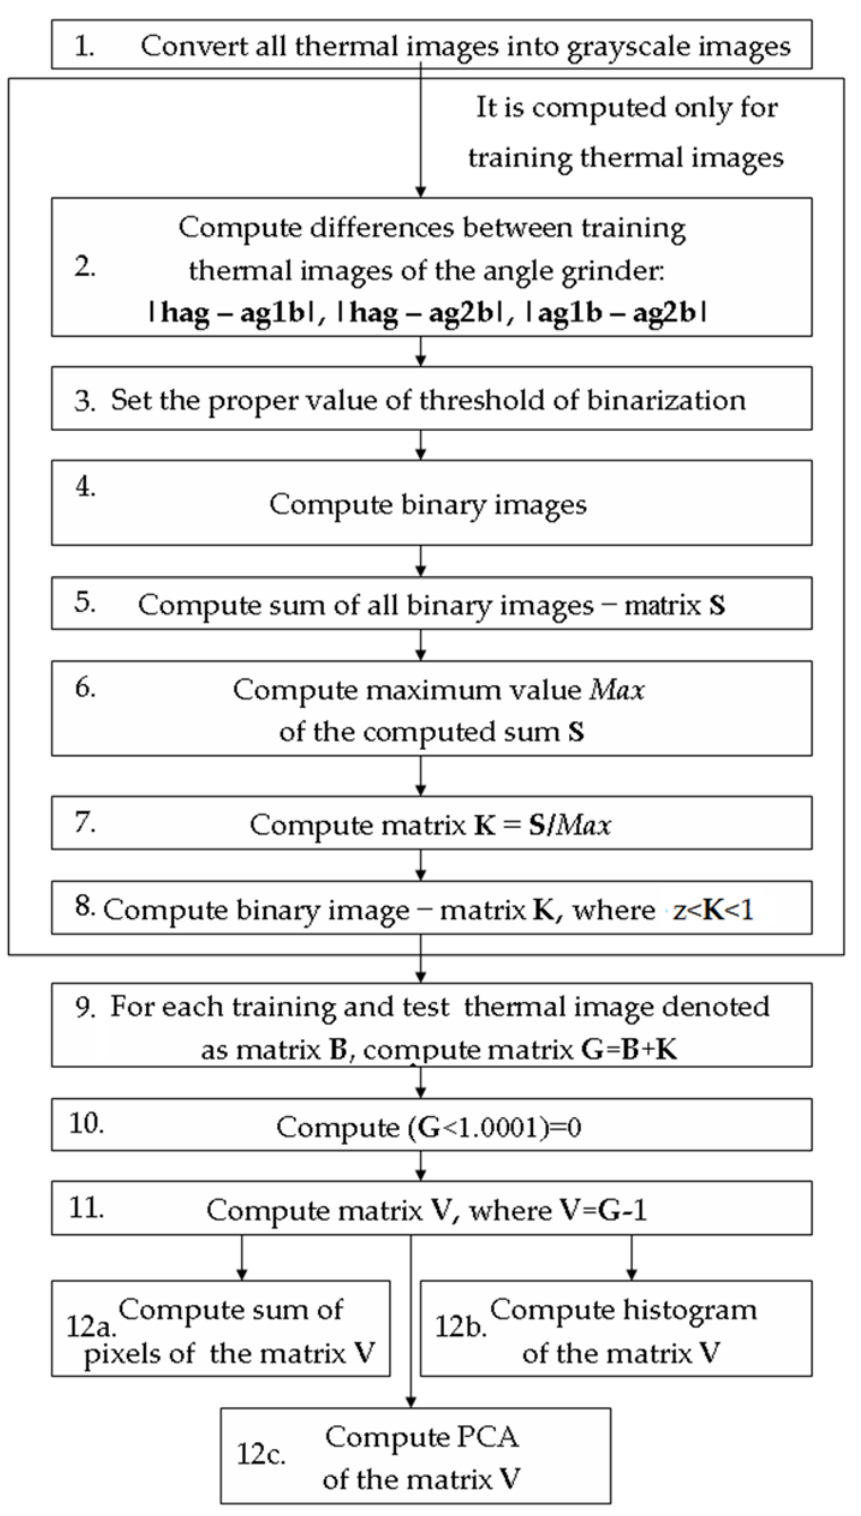
Figure 7. Flowchart of the feature extraction method BCAoMID − F.